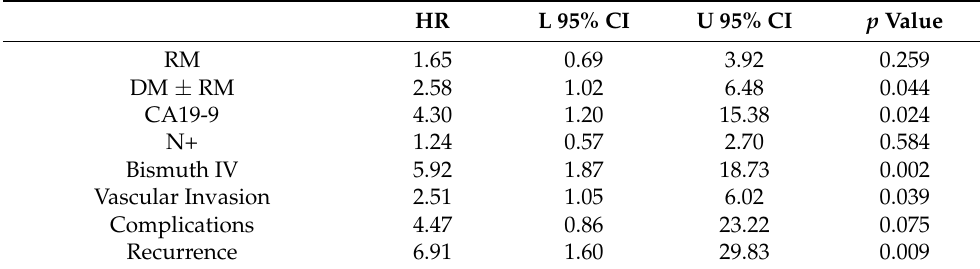
Table 5. Multivariate analysis for survival prognostic factors.